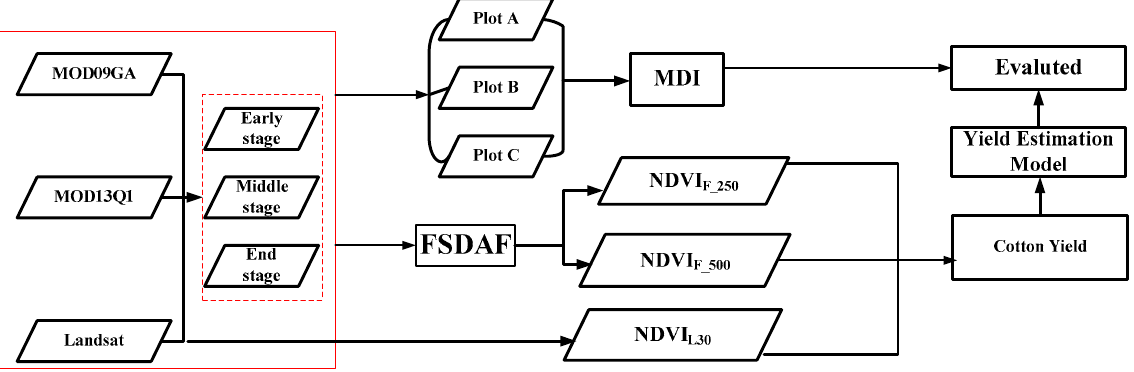
Figure 7. Flow chart of the technique employed in this study.